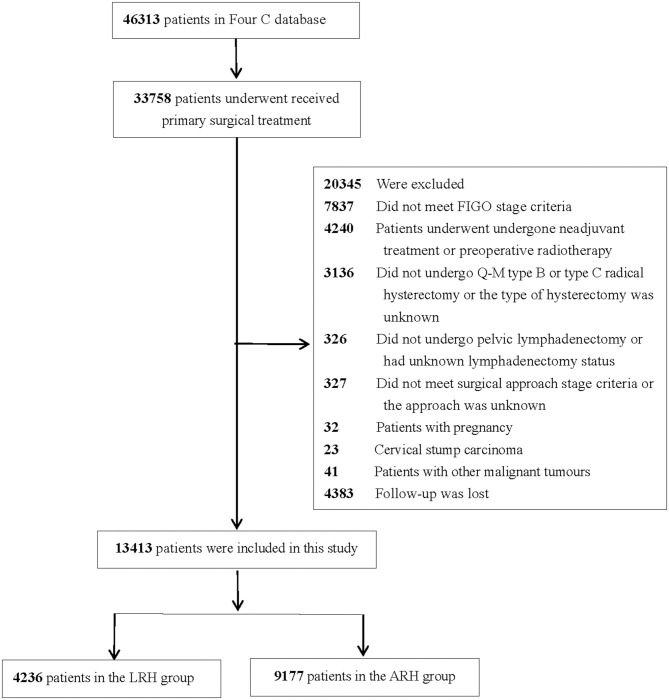
Flowchart of patients included in the analysis.